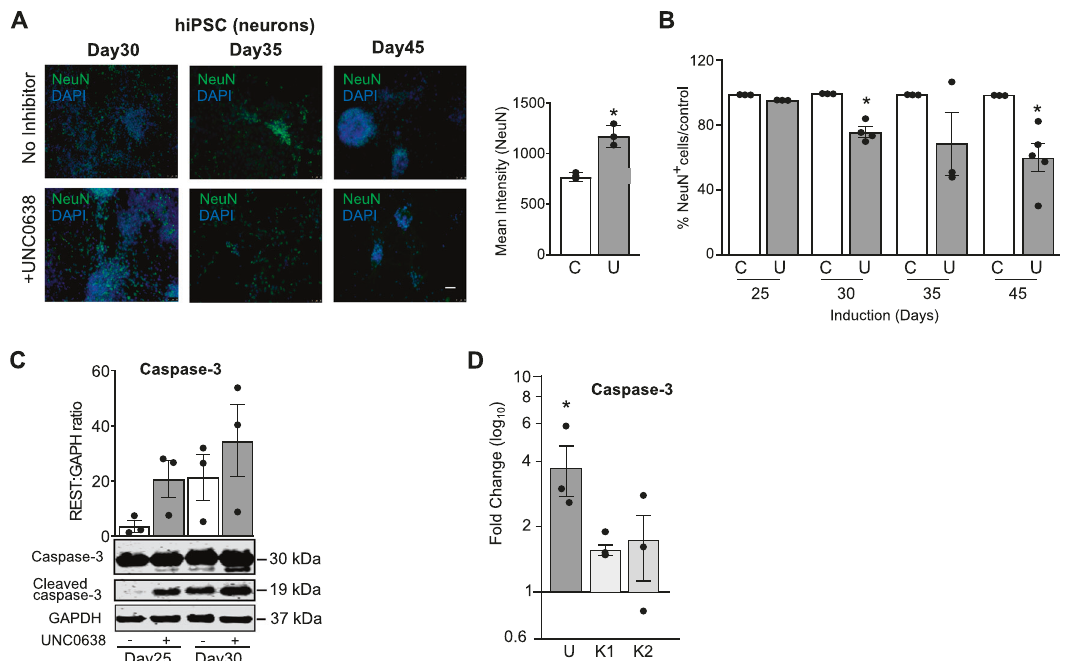
Fig. 5 Adjustment of neuronal cell numbers during later differentiation. A Representative immunocytochemistry images of hiPSCs-derived neurons treated with UNC0638 (250 nM) at days 30, 35 and 45 of differentiation stained with NeuN (green) and counterstained with DAPI (blue). Scale Bar, 50 µM. Graph shows quantitation of NeuN expression (mean average intensity of cell nuclei, all data shown) at day 35 time point. B Total number of NeuN-cells at days 25, 30, 35 and 45 of differentiation in the absence and presence of UNC0638, n ≥ 3 independent experiments. C Western blot analysis at days 25 and 30 to examine the expression of cleaved-caspase-3 in the presence and absence of UNC0638 (250 nM). Top panel shows the expression of uncleaved caspase-3 (inactive), middle panel shows the expression of cleaved-caspase- 3 (activated) and bottom panel shoes expression of GAPDH. Quanti fi cation of Western blot analysis was performed by normalization to GAPDH, n ≥ 3. D qRT-PCR analysis to examine the change in the expression of caspase-3 in hiPSCs-derived neurons treated with UNC0638 (250 nM). The expression of caspase-3 increased in UNC0638-treated neurons and patient iPSC compared to untreated neurons. Fold change over untreated neurons (mean). n ≥ 3 independent experiments. Data were presented as Mean±SEM and analysed by student ’ s t-test or One- way ANOVA with post hoc comparisons using Dunnett ’ s multiple comparisons test comparing to control